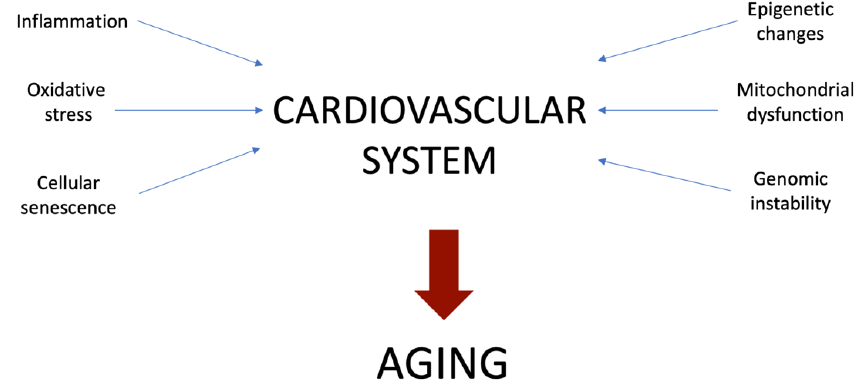
Figure 1. Schematic representation of main cellular mechanisms contributing to aging.